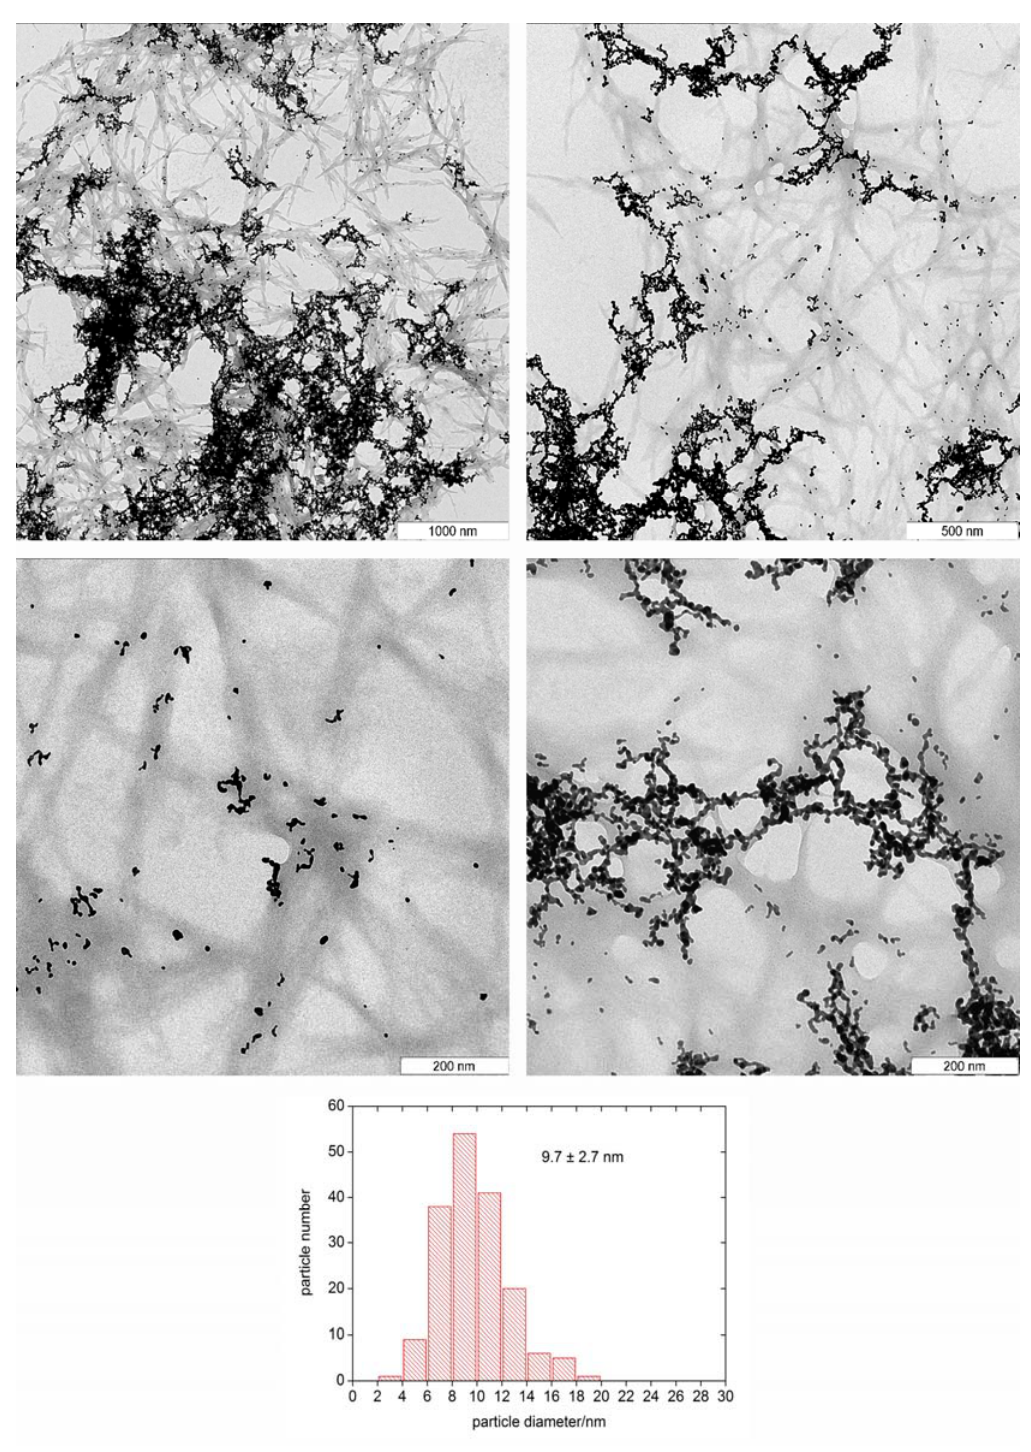
Figure 2. TEM images and gold particle size distribution of the sample shown in Figure